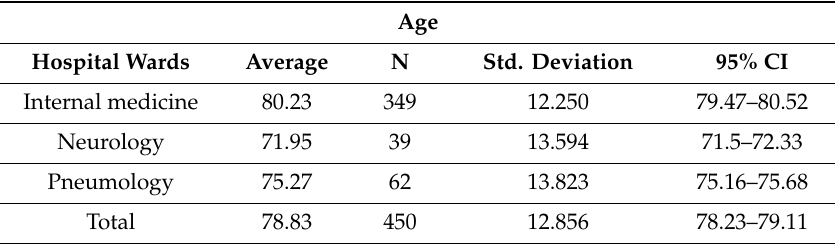
Table 3. Average age by hospital